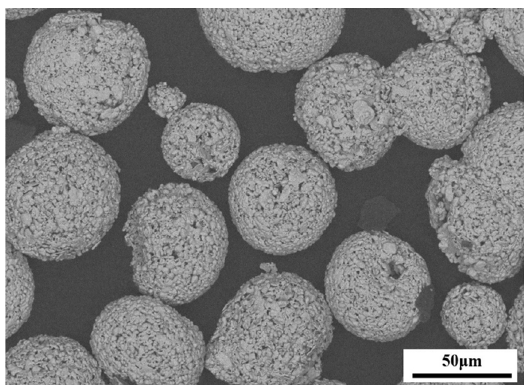
Figure 1. Morphology of alloy